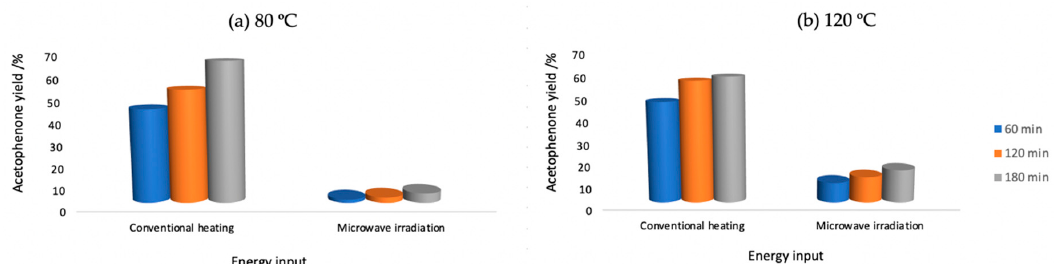
Figure 8. Acetophenone yields obtained from the oxidation of 1-phenylethanol by TBHP, catalyzed by Fe 3 O 4 /TiO 2 /[FeCl 2 { κ 3 - HC(pz) 3 }] under different (conventional thermal heating and microwave irradiation) energy inputs, reaction times (1–3 h) and temperatures: ( a ) 80; ( b ) 120 °C. Table 3. Selected catalytic results for the oxidation of 1-phenylethanol into acetophenone using, as